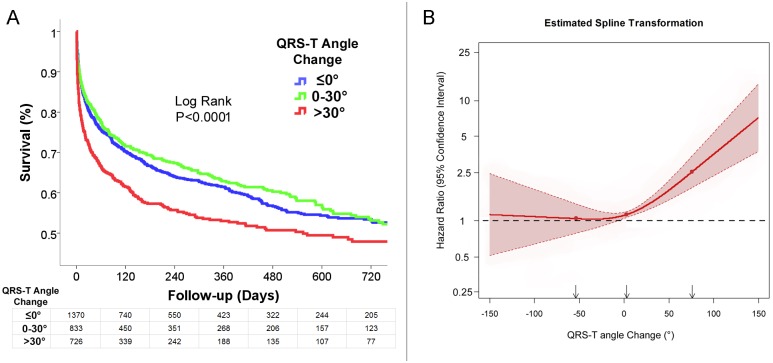
Widening of the QRS-T angle on follow-up was associated with increased mortality.(A) Kaplan Meier survival analysis according to QRS-T angle change calculated by the difference between follow-up and baseline ECG. An increase in the QRS-T angle on follow-up above 30° was associated with an increased mortality. The estimated cumulative survival rate at the median follow-up time of 342 days was reduced with an increased QRS-T angle difference; 61.9±1.5% vs 63.6±1.9% vs. 53.3±2.0%, Log rank P<0.00001. (B) Cox regression analysis with adjusted hazard ratio for mortality (with 95% confidence interval) of the QRS-T angle change as a continuous variable using restricted cubic splines with 3 knots at the 5th, 50th and 95th percentiles of the QRS-T angle change distribution, P<0.0001. Parameters included were parameters outlined in Table 3 with the addition of baseline QRST-T angle.